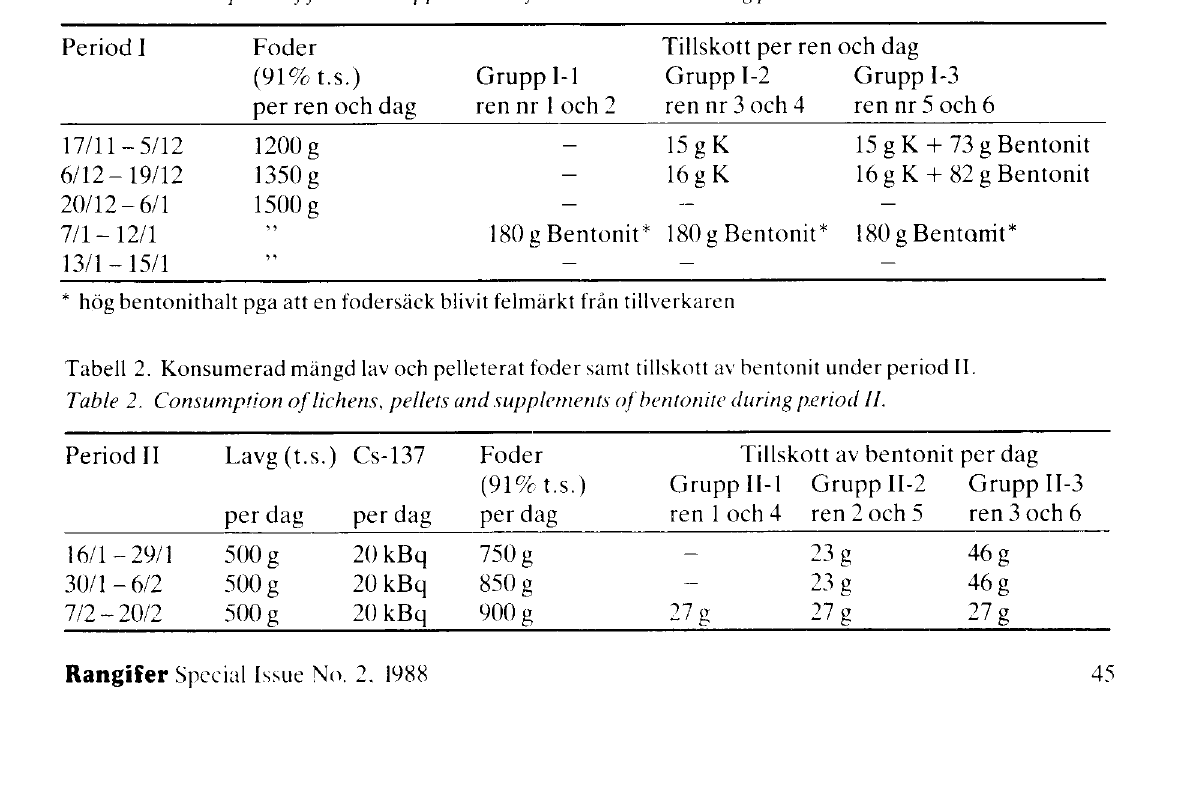
Table 1. Consumption of feed and supplements of K and bentonite during period I. Period I